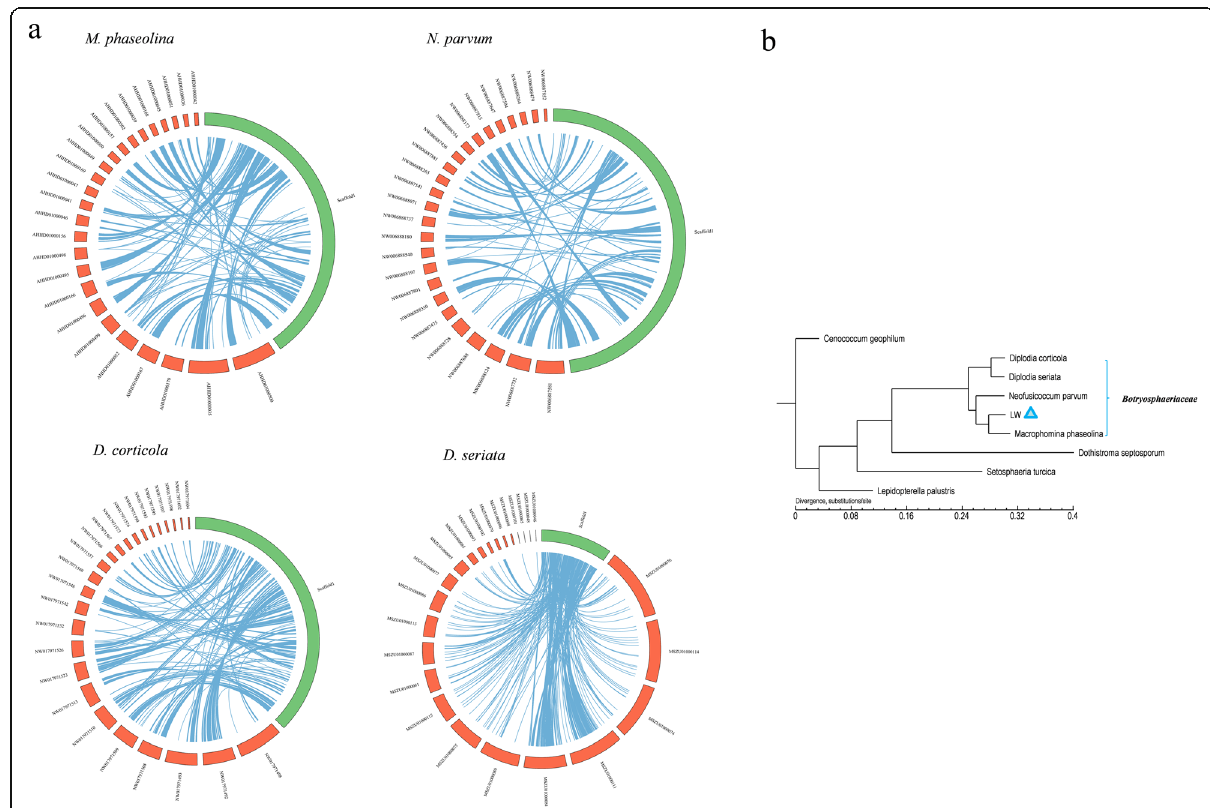
Fig. 5 Synteny analysis and phylogenetic tree analysis of Botryosphaeria dothidea LW-Hubei with other fungal strains. a Synteny relationship between scaffold1 of B. dothidea LW-Hubei and that of Macrophomina phaseolina, Neofusicoccum parvum, Diplodia corticola and Diplodia seriata are indicated by connected lines; b Phylogenetic tree analysis based on core-pan genes from B. dothidea LW-Hubei and eight other fungi using the neighbor-joining method. The scale number represents branch